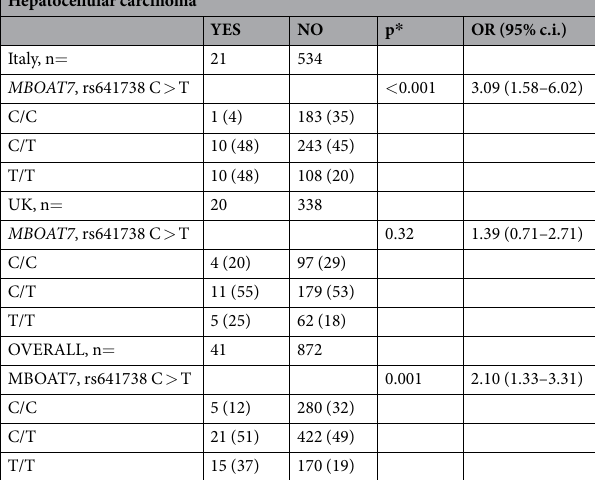
Table 4. Frequency distribution of the rs641738 C > T genotype in 913 patients without advanced liver fibrosis/ cirrhosis from the Italian and UK cohorts stratified by HCC diagnosis. * Comparisons were performed by logistic regression setting HCC as dependent variable, and the association of genetic variants was analyzed assuming additive models. (): % values; OR, 95% c.i.: allelic odds ratio and 95% confidence intervals.